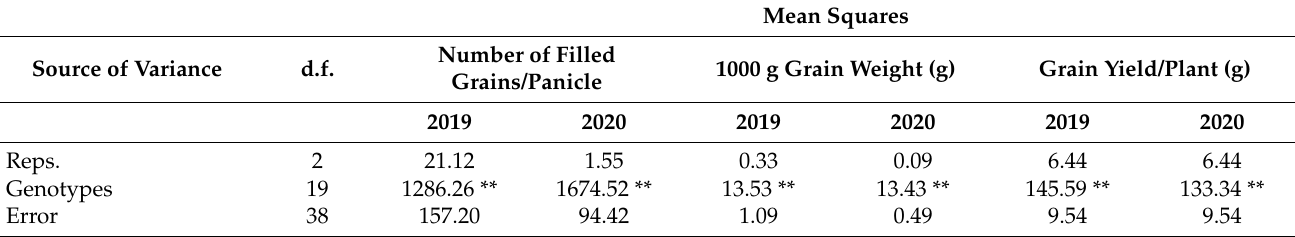
Table 4. Analysis of variances of number of filled grains/panicle, 1000 g grain weight and grain yield/plant of twenty rice genotypes over two years.